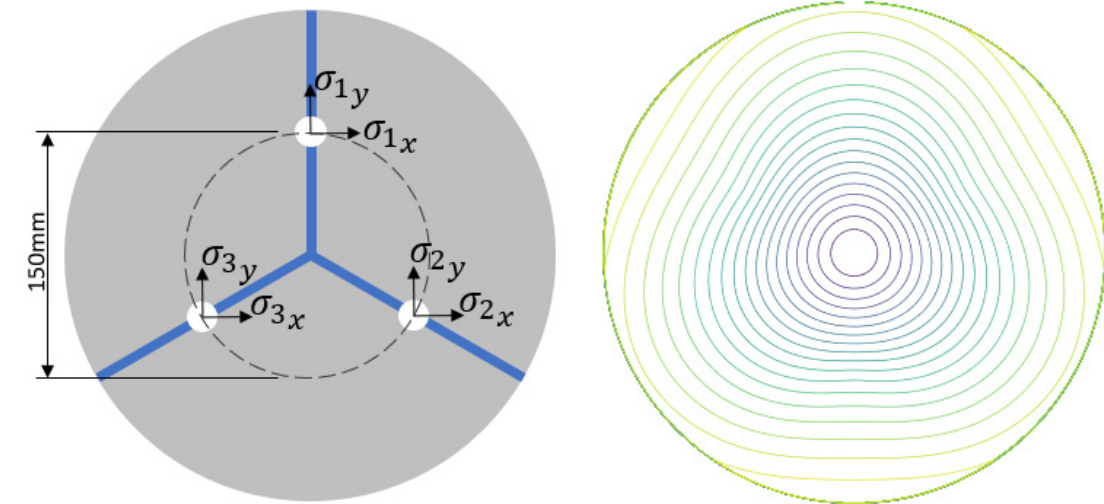
Figure 4. Left , three-point support layout. Right , contour map of a dense gravity effect. For the reference method, the normal direction measurement 𝑦 with zero mean and a variable standard deviation